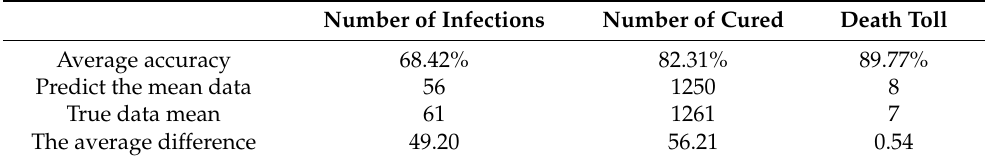
Figure 16. Epidemic trend based on SEIARN that trend chart for lurkers and reapers. Table 3. Statistics of the SEIARN